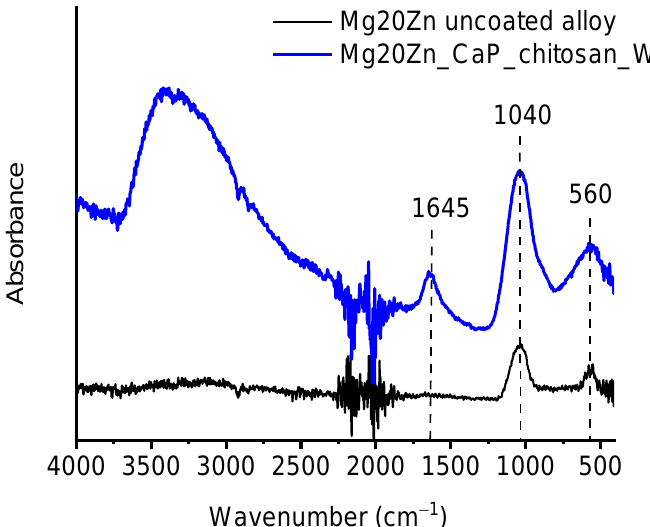
Figure 8. FTIR spectra of the Mg20Zn alloy (black curve) and the Ca-P/chitosan_WG coating (blue curve) after immersion in the Hank solution for 110 h. The relevant bands are described in the text.